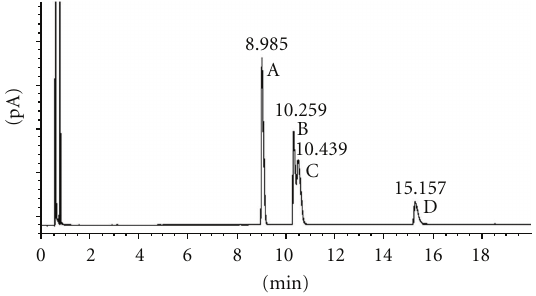
Figure 5: Chiral GC analysis of the cis -1,2-cyclohexanediol acetates: (A) cis -1,2-cyclohexanediol diacetate; (B) (+/ − )- cis - 2-hydroxycyclohexyl acetate; (C) (+/ − )- cis -2-hydroxycyclohexyl acetate; (D) cis